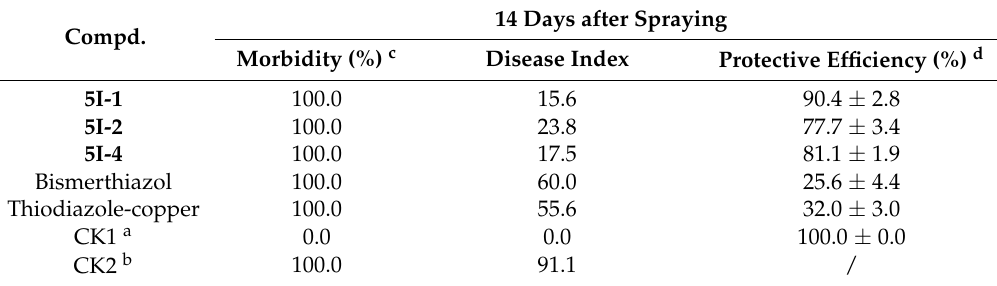
Table 3. In vivo Inhibitory Effect of Testing Compounds against X. oryzae at 200 µ g/mL. 14 Days after Spraying Compd. Morbidity (%) c Disease